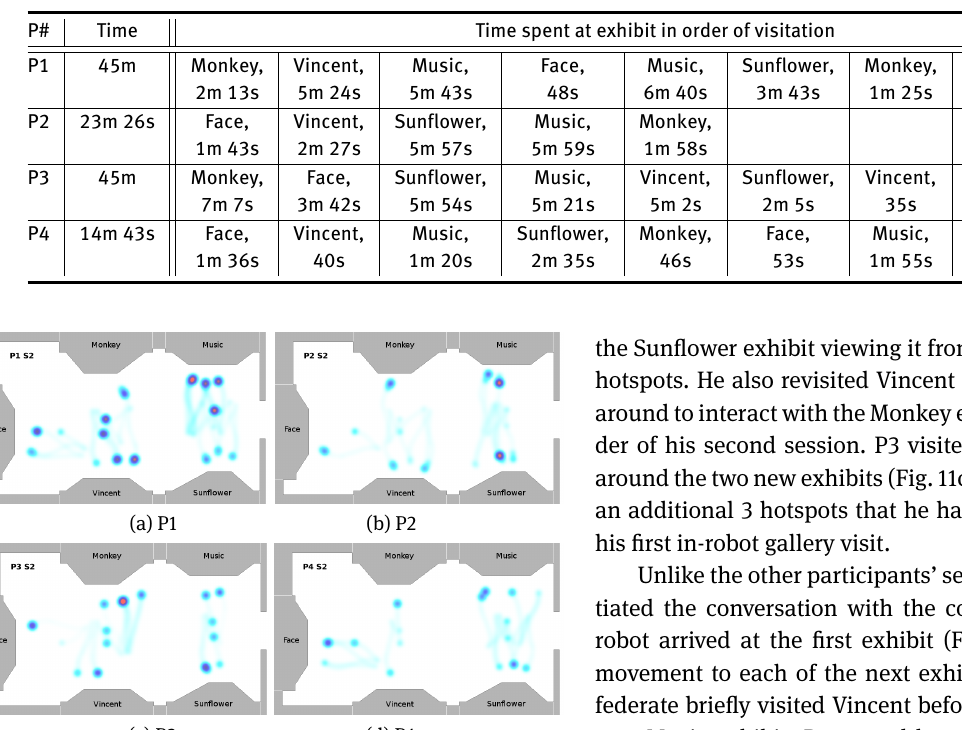
between the exhibit’s right and info hotspot. They then went to the Face exhibit where P3 stationed the robot at the exhibit’s right hotspot for the duration of the conver- sation. Of the two next exhibits, P3 and the confederate went first to the Sunflower exhibit and then to Music. P3 viewed the Sunflower exhibit from its right hotspot, and the Music exhibit from its center and right hotspots. The confederate visited the Vincent exhibit before